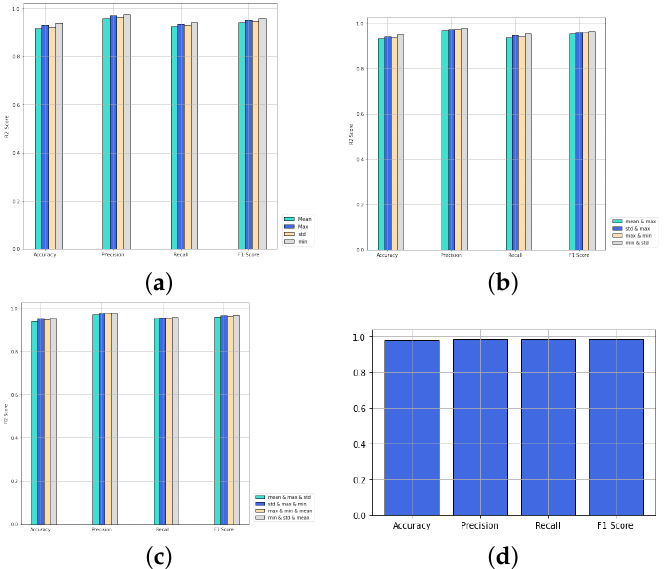
Figure 11. Performance of PNA-GCN with variable numbers of aggregators. ( a ) One aggregator; ( b ) two aggregators; ( c ) three aggregators; ( d ) four